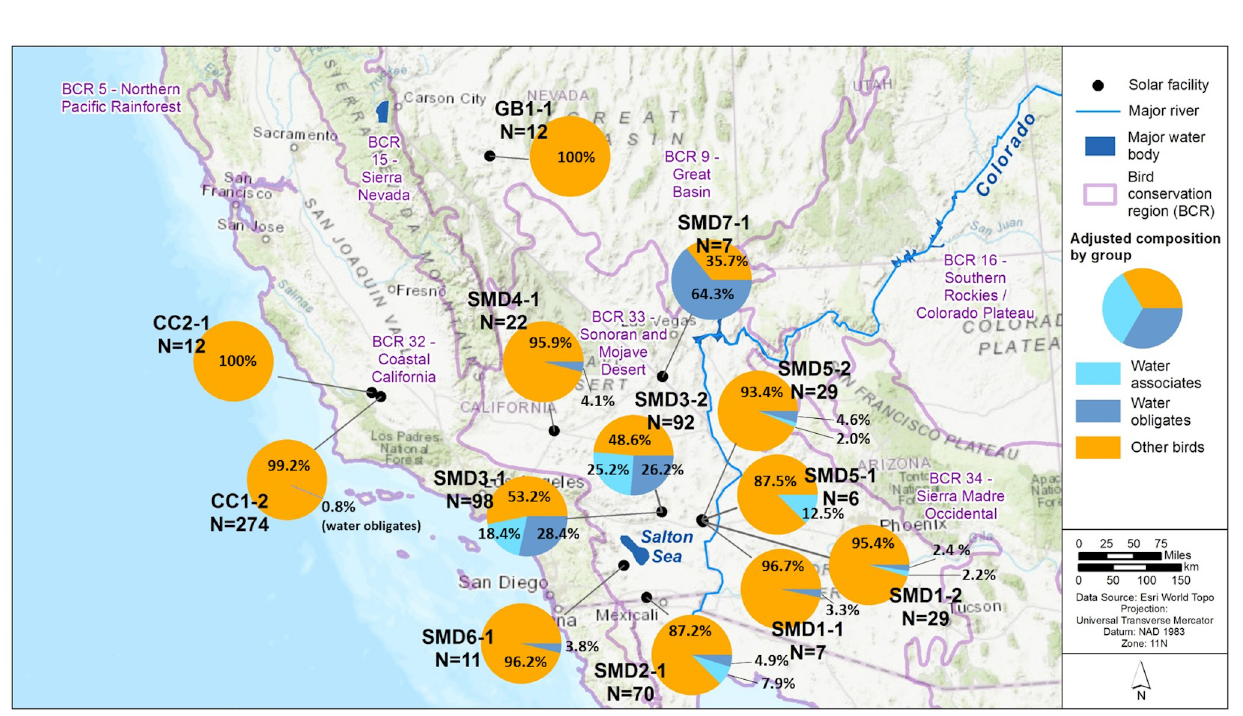
Fig 4. Adjusted composition of water obligates, water associates, and other birds for 13 fatality monitoring site-years at photovoltaic solar facilities in California and Nevada from January 1, 2013, to September 1, 2018. Water associates are species that rely on water for foraging, reproduction, and/or roosting; water obligates are species that cannot take flight from land; other birds are birds not falling into either of those categories. N = total number of detections for each site-year (e.g., CC2-1) represented on the map.